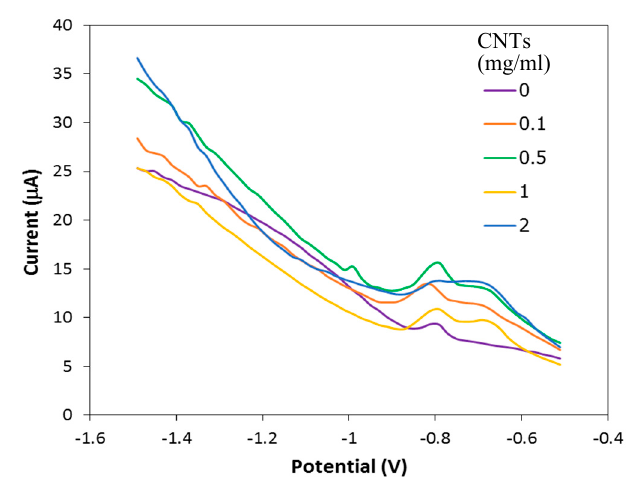
Figure 3. DPASV for analysis of 200 µg/L Pb using Graphene/PDMS with different CNT contents.